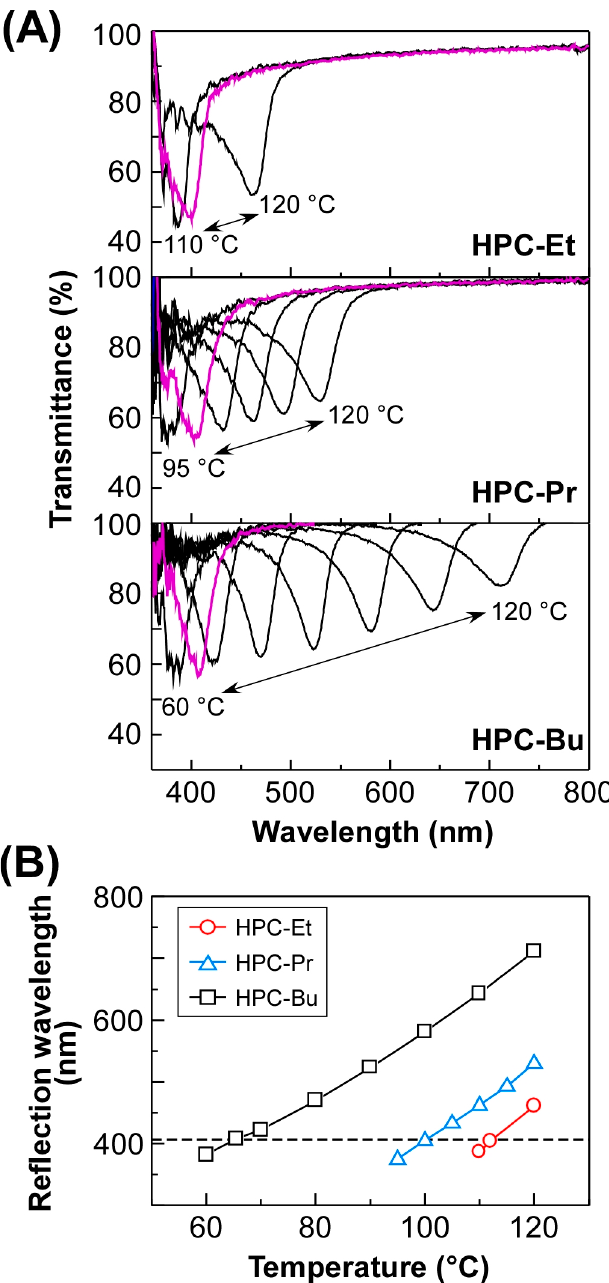
Figure 3. Reflection properties of a series of HPC derivatives upon changing the temperature. ( A ) Changes in the transmission spectra of HPC-Et (upper panel), HPC-Pr (middle panel), and HPC-Bu (lower panel) in the temperature range between 60 and 120 °C. Each spectrum was recorded at the intervals of 10 °C for HPC-Et, 5 °C for HPC-Pr, and 10 °C for HPC-Bu (black lines). A reflection peak appeared at 405 nm by heating at 112 °C for HPC-Et, 100 °C for HPC-Pr, and 66 °C for HPC-Bu (purple lines). ( B ) Temperature dependences of reflection peak wavelengths of HPC-Et (red circles), HPC-Pr (blue triangles), and HPC-Bu (black squares). The horizontal dotted line corresponds to the reflection peak wavelength of 405 nm.